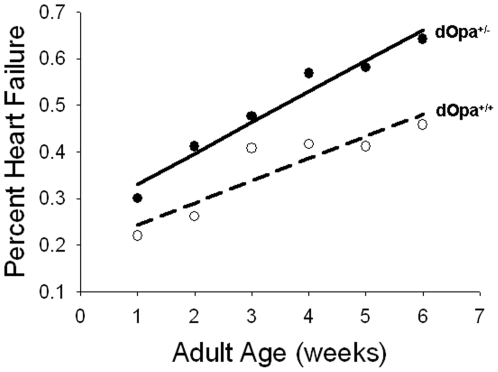
Heterozygous mutation of dOpa1 results in increased heart failure (solid line) compared to controls (dashed line).Heart failure here is defined as cardiac arrest or fibrillation after a two-minute recovery period following electrical pacing. Heart failure increased with age for both controls and mutants, but was significantly higher in mutants. 40 males and 40 females of each genotype were tested at every age.